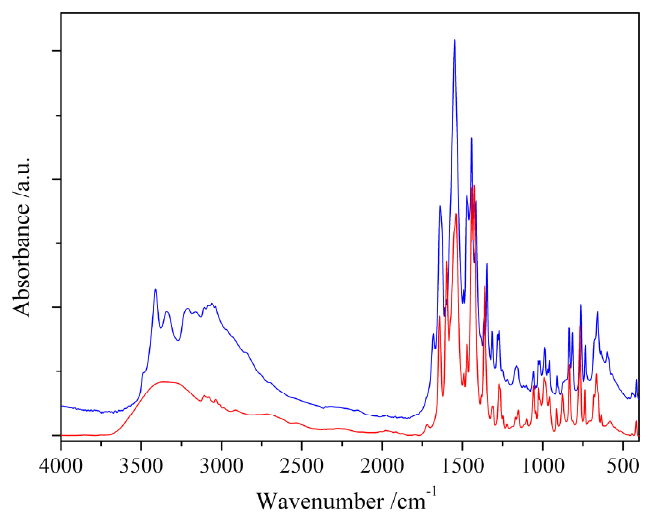
Figure 3. IR spectra of [Ni(bpy)(acr) 2 (H 2 O)] (red) and [Ni(bpy)(acr) 2 (H 2 O)]·MA